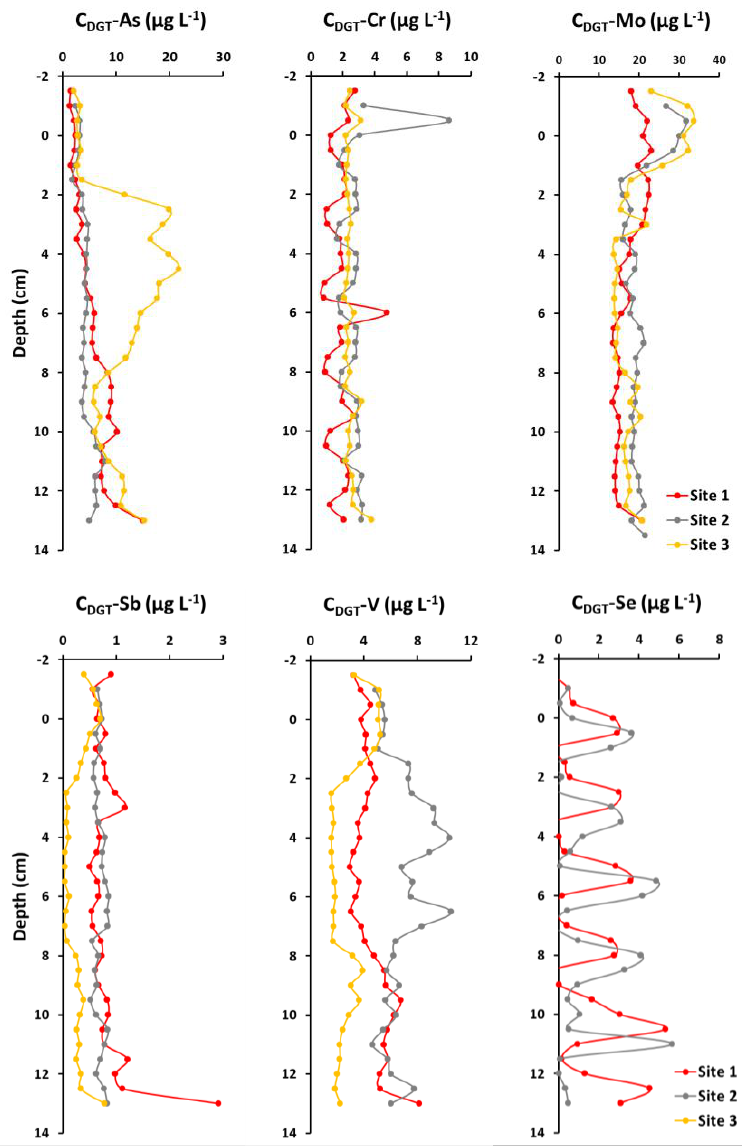
Figure 2. Vertical distributions of DGT-labile As, Cr, Mo, Sb, V and Se in the sediment-overlying water profiles at studied locations.